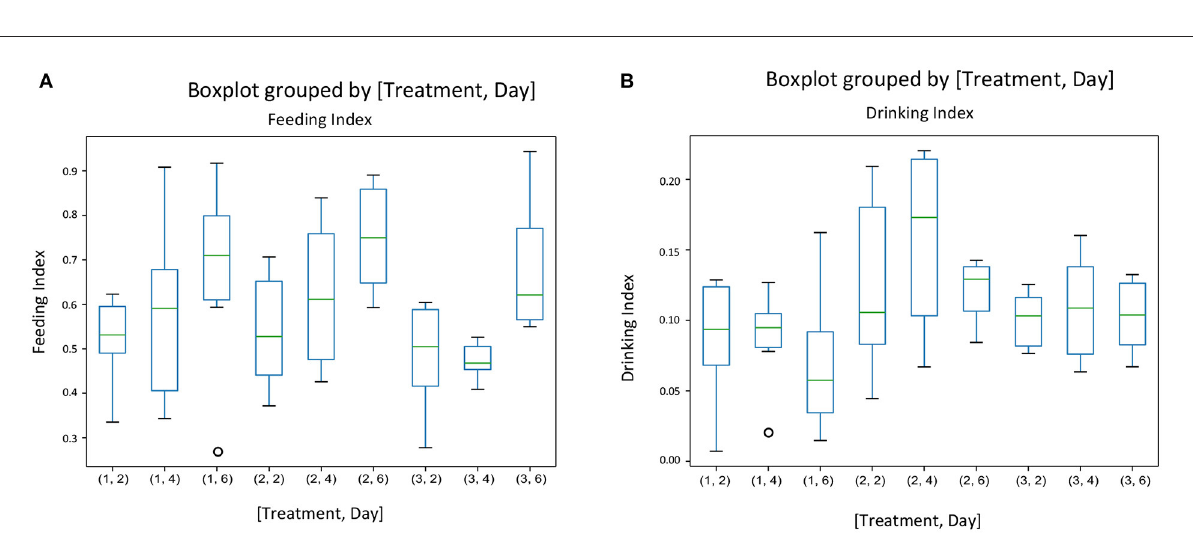
FIGURE3 The behavioral indices for feeding (A) and drinking behavior (B) for each treatment and each experimental day assessed (Days 2, 4, and 6 of the first week of the experiment) in pens of pigs receiving different dietary treatments. Weaner pigs received dietary treatments with added ZnO (T1), non-supplemented control (T2) or added antibiotics (T3). The plots are depicting groups of numerical data through their quartiles. The box extends from the Q1 to Q3 quartile values of the data, with a line at the median (Q2). The whiskers extend from the edges of the box to show the range of the